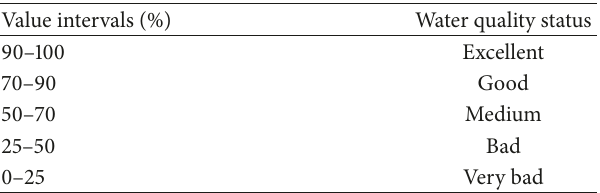
Table 1: Index value intervals and the corresponding quality category